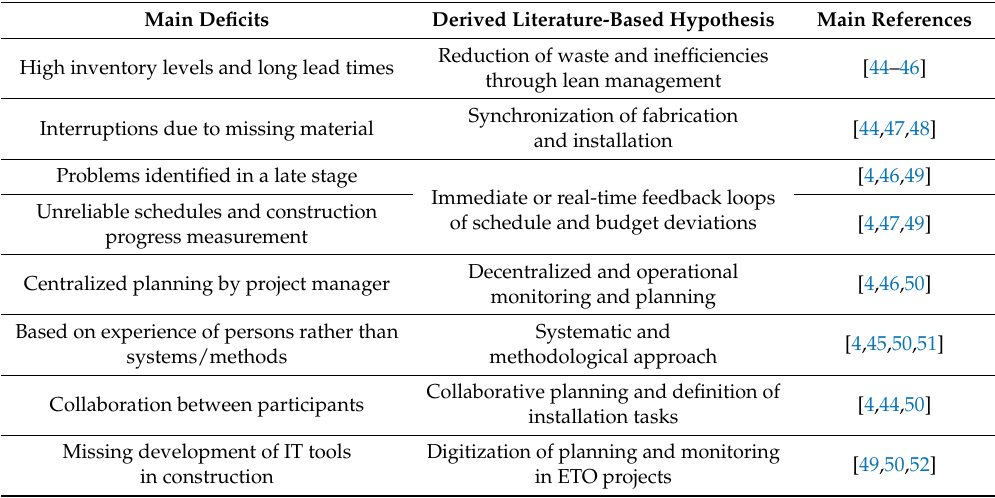
Table 2. Deficits and main requirements based on literature